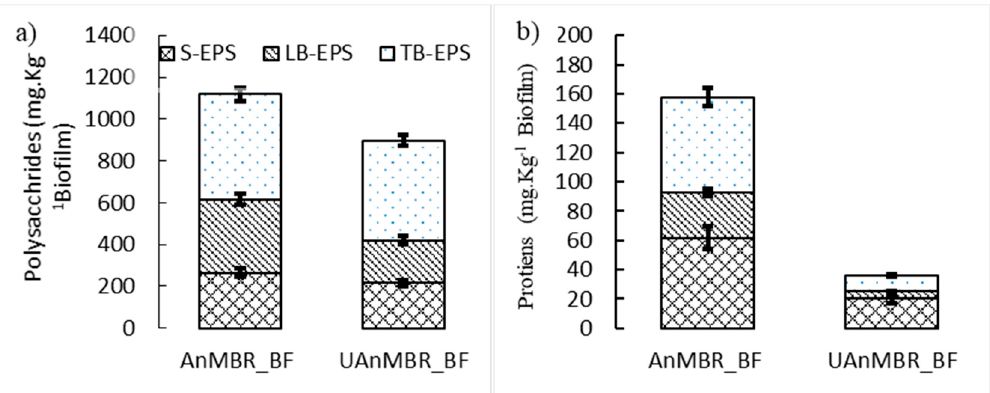
Figure 2. Acyl homoserine lactone (AHL) concentrations in the biofilm (ng kg − 1 ) and sludge (mg L − 1 ) of ( a ) UAnMBR and UASB (sludge only), ( b ) AnMBR (error bars show standard deviation of replicates; n = 2); the y ‐ axis is a log scale. AHL abbreviations are; C4: C4 ‐ HSL; C6: C6 ‐ HSL; C8: C8